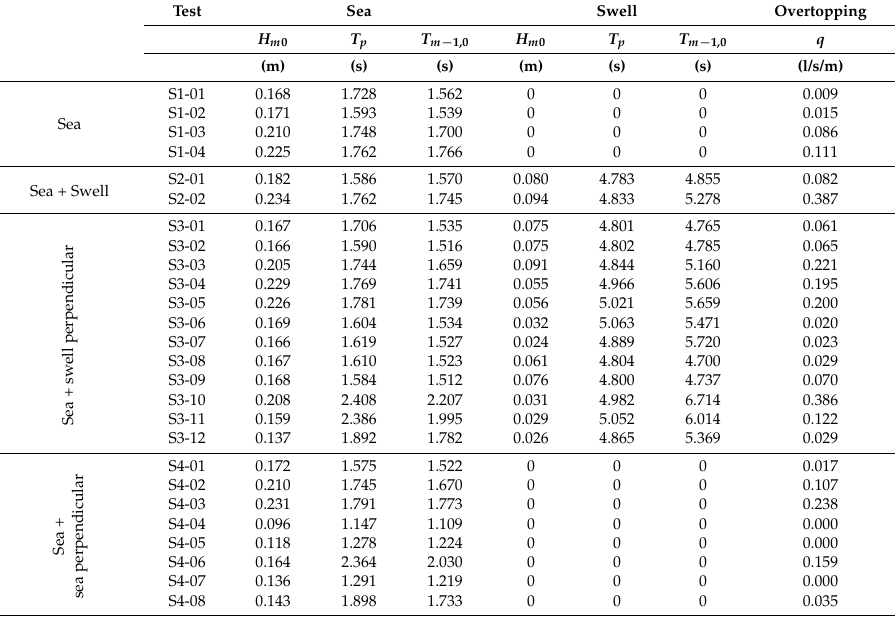
Table 1. Measured wave conditions and measured wave overtopping